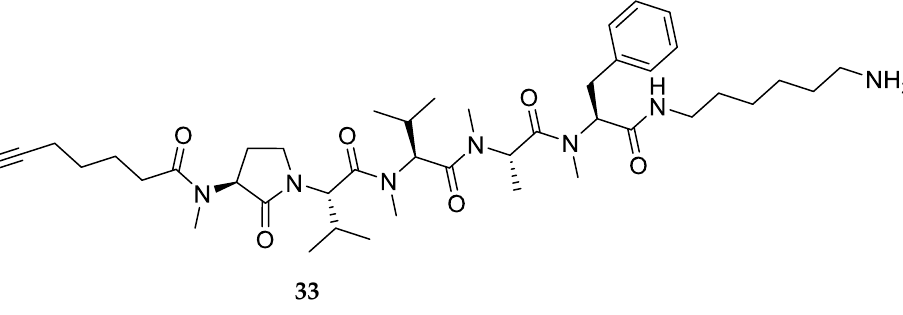
the synthesis of peptide 18 using Fmoc-Agl-(D,L)-Phe-OH (1.03 g, 3 eq.), the mixture of two diastereoisomers was prepared and separated by HPLC on C18 column using a gradient of 50% to 90% MeOH in H 2 O to obtain peptide 32 (1 mg, 1%), which was shown to be >95% pure by LC-MS analysis [50 − 90% MeOH (0.1% FA) in H 2 O (0.1% FA), 14 min, RT 5.31 min] and peptide 39 (0.9 mg, 1%), which was shown to be >95% pure by LC-MS analysis [50 − 90% MeOH (0.1% FA) in H 2 O (0.1% FA), 14 min, RT 5.07 min].